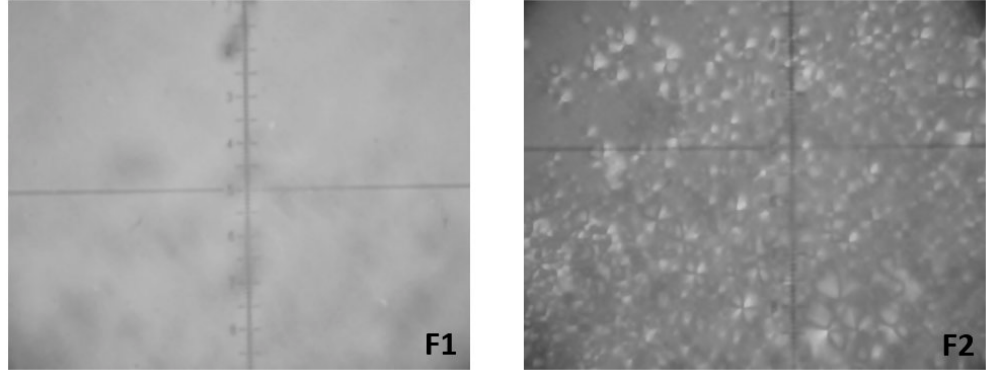
Figure 3. Photomicrographs obtained using polarized light microscopy (PLM) showing isotropy of microemulsion (F1) and Maltese cross of lamellar phase (F2).